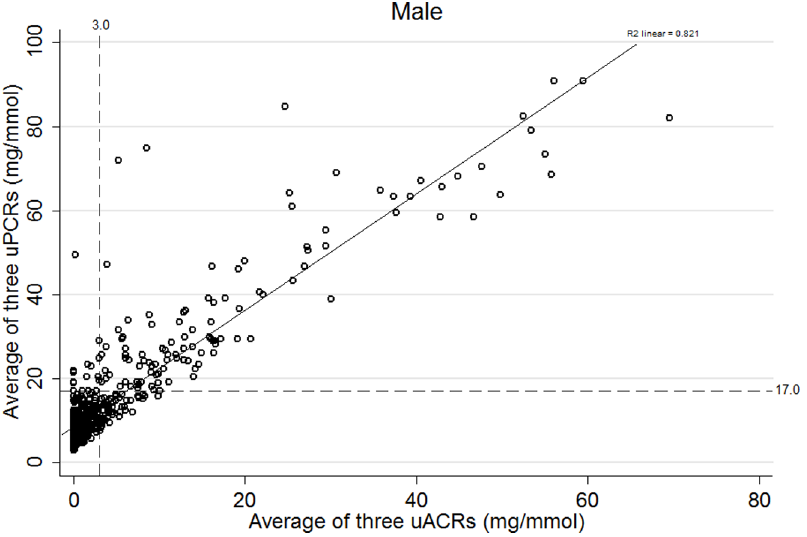
Figure 2. Scatterplot showing the distribution of uACR and uPCR relative to clinically important threshold values for males (excluding outlier values (ACR over 70 mg/mmol and PCR 150 mg/mmol)). Explanatory footnote for Figure 2: High values have been excluded (uACR . 70 mg/mmol and uPCR . 150 mg/mmol) to better illustrate the relationship at lower levels of proteinuria.